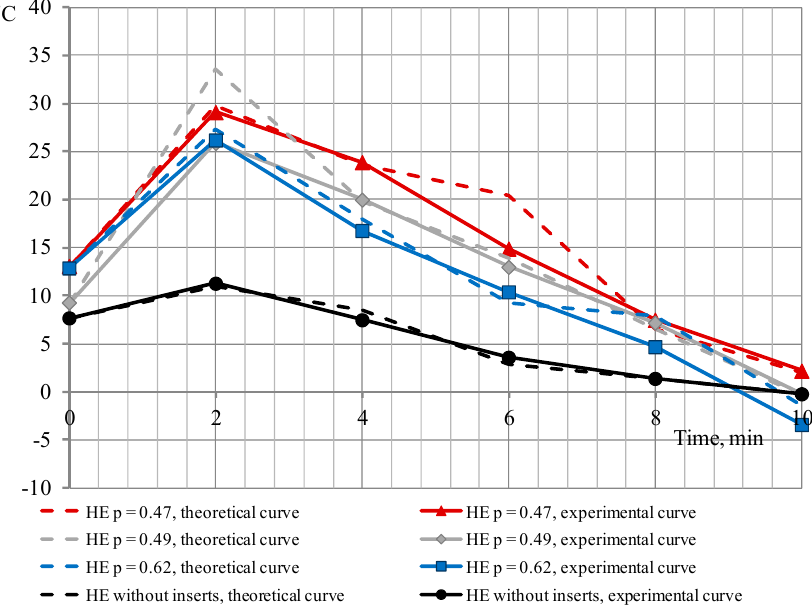
Figure 6. Calculated freon temperature at the outlet of the heat exchanger and their comparison with experimental data.